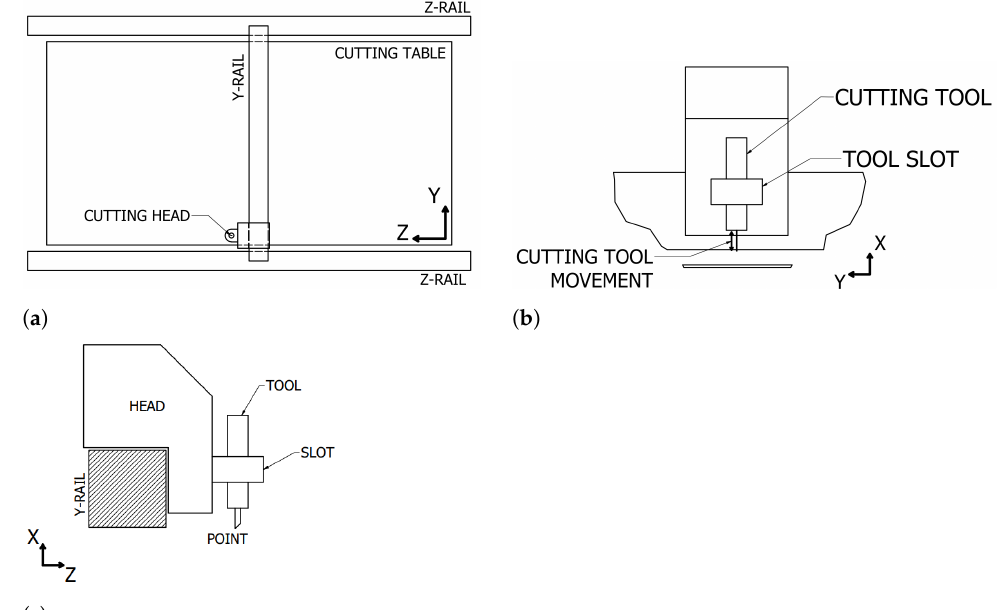
Figure 2. Simplified scheme: ( a ) Cutting machine, ( b ) cutting head (front view), ( c ) cutting head (side